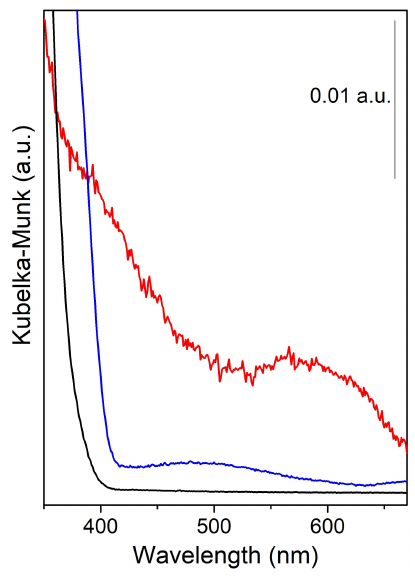
Figure 3. UV-Vis spectra of MoS 2 /TiO 2 (red curve), sulfided-TiO 2 (blue curve) and pure TiO 2 used as a reference (black curve).